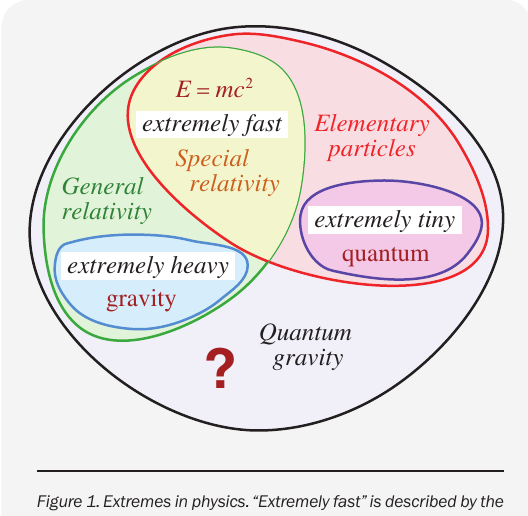
Figure 1. Extremes in physics. “Extremely fast” is described by the theory of Special Relativity; “extremely heavy” leads to Newton’s gravity theory. Combining these two leads to General Relativity. “Extremely tiny” leads to quantum theory, and combining that with extremely fast gives us the theory of elementary particles. To combine all these extremes into one requires a theory for Quantum Gravity, which is not yet completely